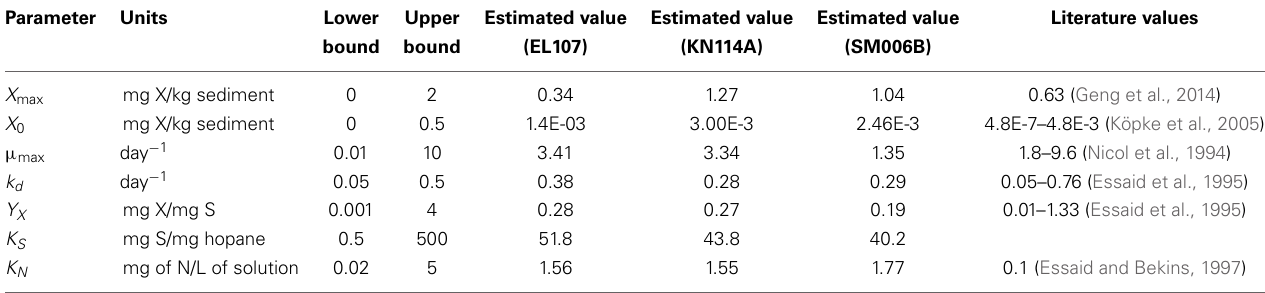
Table 1 | Parameters estimated by the model using individual datasets. Parameter